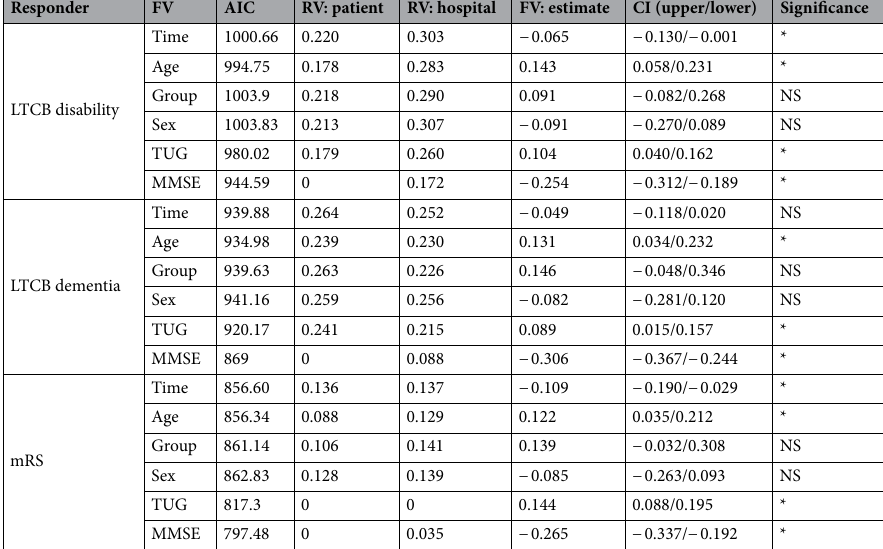
Table 2. Results in GLMM (1): LTCB disability, LTCB dementia and mRS. AIC Akaike Information Criteria, CI 95% confidence intervals, dem dementia, FV fixed variable, GLMM generalized linear mixed model, LTCB